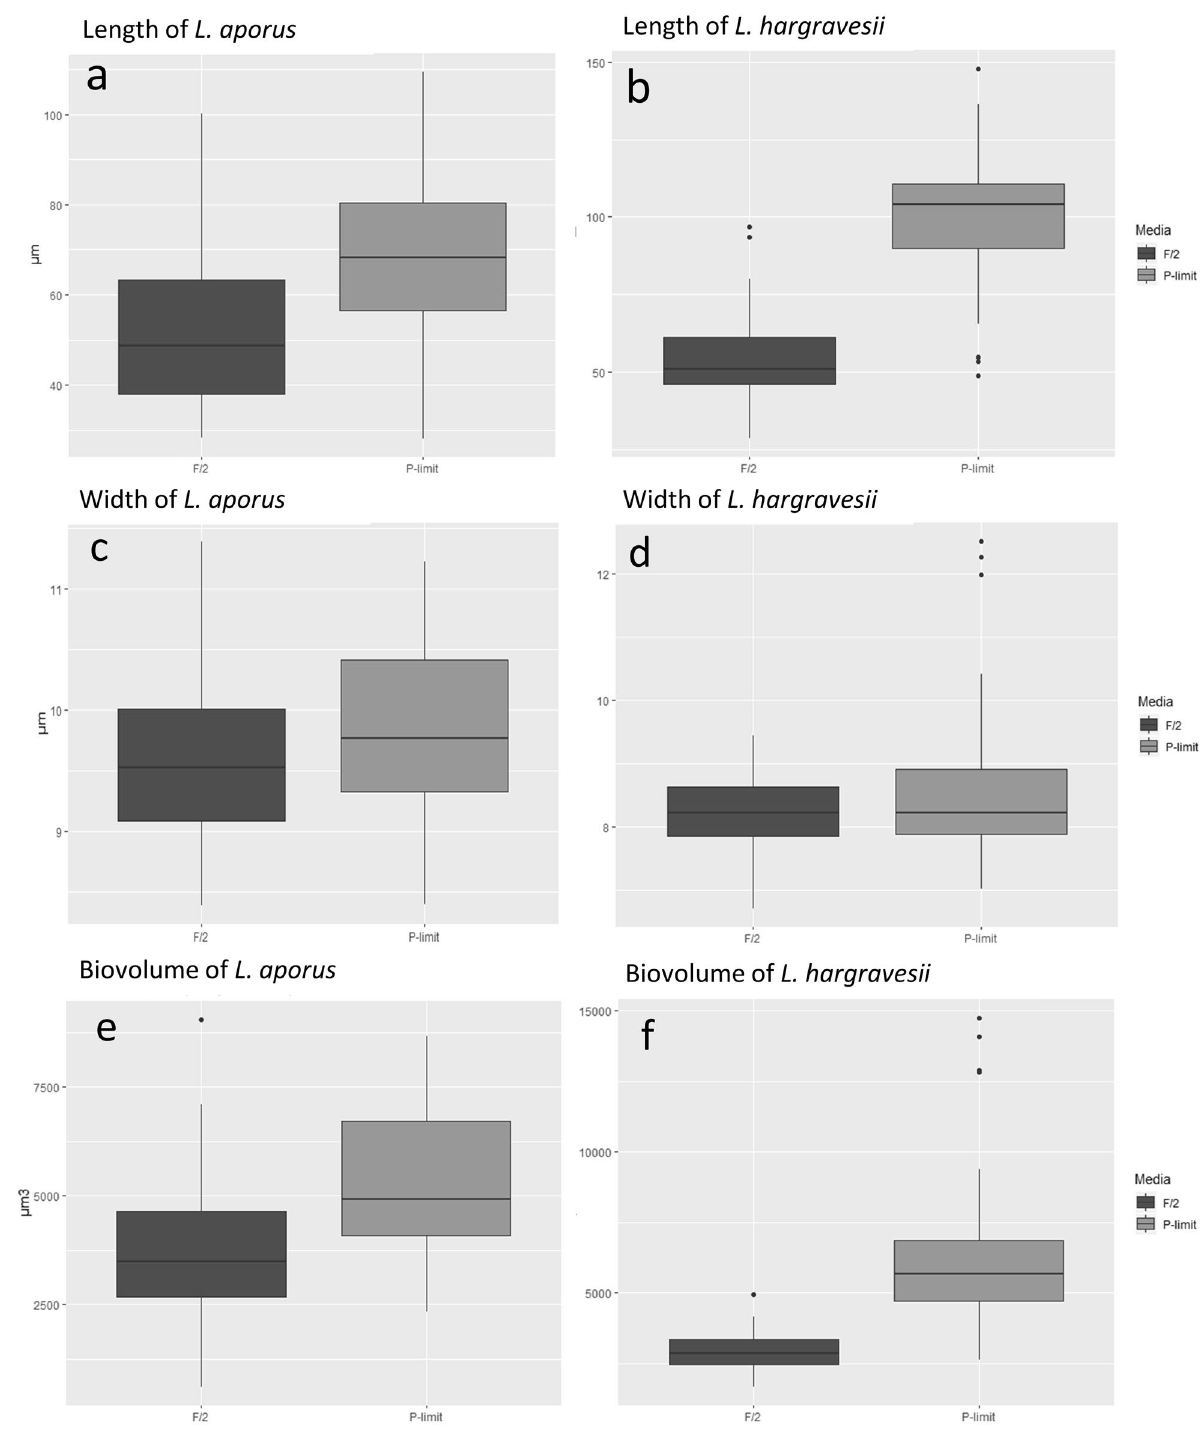
Figure 7. Morphology measurements. Box and whisker plots for the cell length (pervalvar axis) of L. aporus ( a ) and L. hargravesii ( b ), cell widths (apical axis) of L. aporus ( c ) and L. hargravesii ( d ). Biovolume of L. aporus ( e ) and L. hargravesii ( f ), grown in F/2 (dark grey) and P-limit (light grey) ously decreased from the beginning of experiment (3 fmol h −1 cell −1 ) until the end of the exponential growth phase, when it slowly increased again up to 0.8 fmol h −1 cell −1 (Fig. 12a). For L. hargravesii (Fig. 9d) a maximal activity (16 fmol h −1 cell −1 ) was detected at the beginning of the exponential phase, it continuously decreased to a minimum of 2 fmol h −1 cell −1 in the middle of exponential phase, then started to increase again until day 14 when it reached 8 fmol h −1 cell −1 (Fig. 12b). The analysis of the AP enzyme kinetics showed a half saturation constant (K m ) value of 2.51 µM for L. aporus (Fig. 13a) and 13.9 µM for L. hargravesii (Fig. 13b) which indicates a high